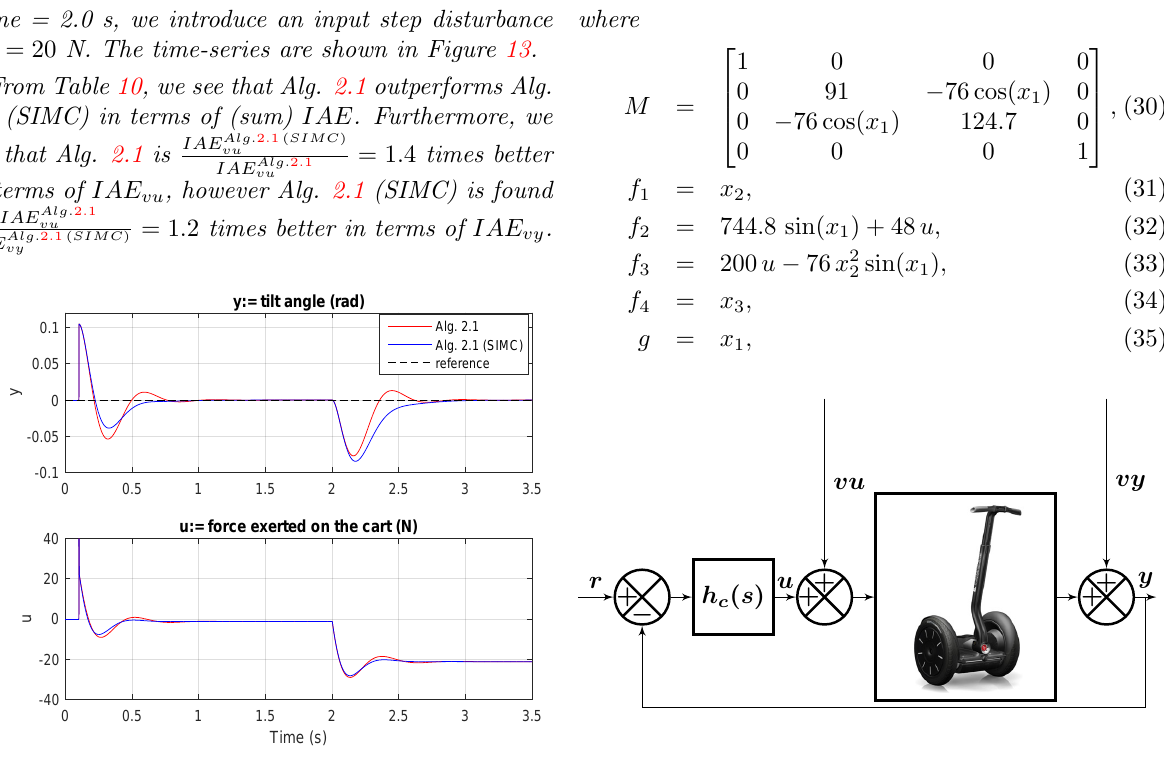
Figure 14: Example 3.8. Feedback system. Segway, and PID controller, h c ( s ). The input, u , is the motor drive voltage, y , is the tilt angle, vu , is input additive disturbance and, vy , is the output additive disturbance.